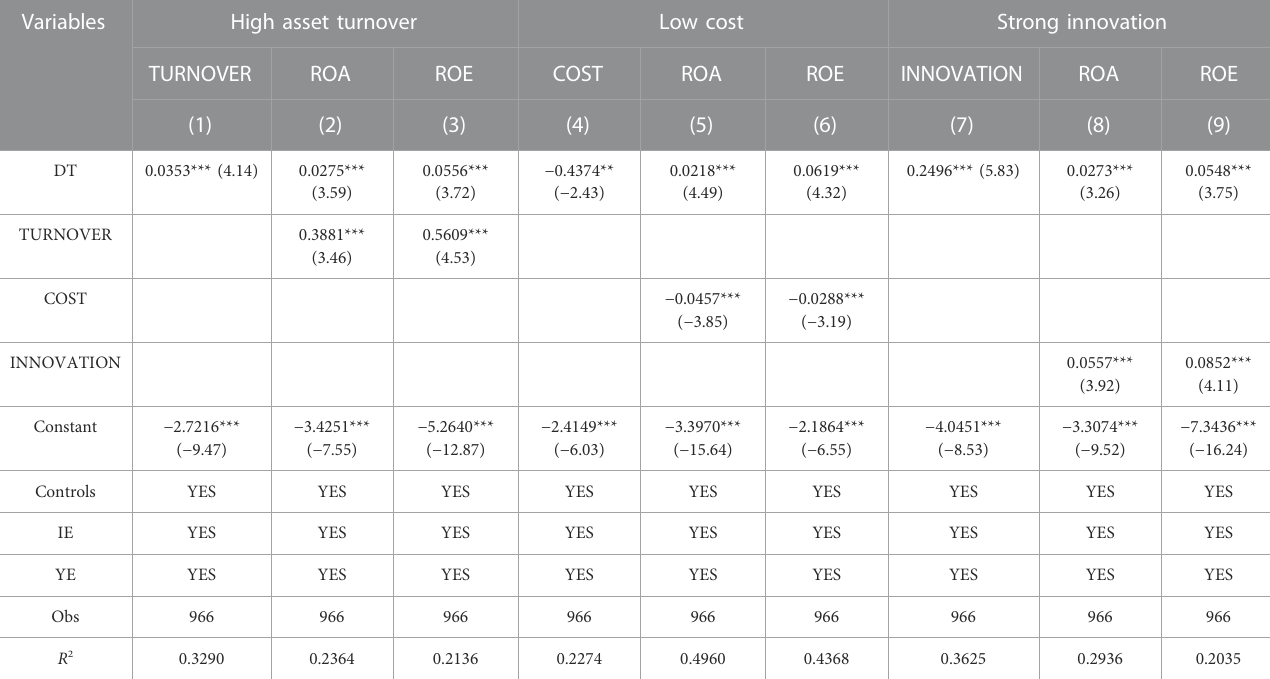
TABLE 10 Transmission